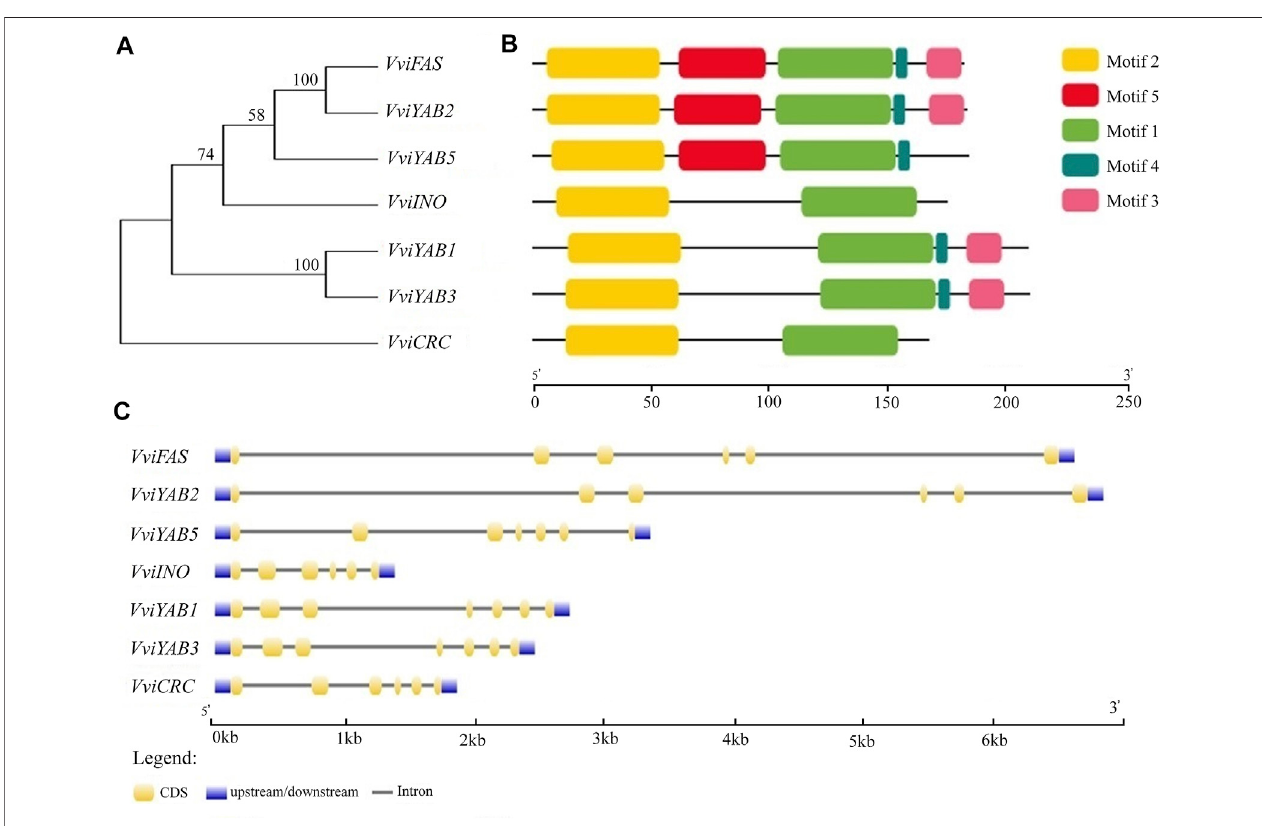
FIGURE 2 | Phylogenetic analysis, gene structure, and conserved motifs of YAB family in grapevine. (A) The conserved YABBY domain sequences of VviYAB proteins constructed a neighbor-joining (NJ) phylogenetic tree, and the bootstrap test was performed with 1,000 iterations. (B) Distribution of conserved motifs of VviYABproteins. Differentmotifsareshown bydifferentcolorsnumbered 1to5.Seelegendfordetailedcolor. (C) Exon – intronstructure of VviYAB genes.Blueindicates untranslated 5 ′ - and 3 ′ - regions, yellow indicates exons; black indicates